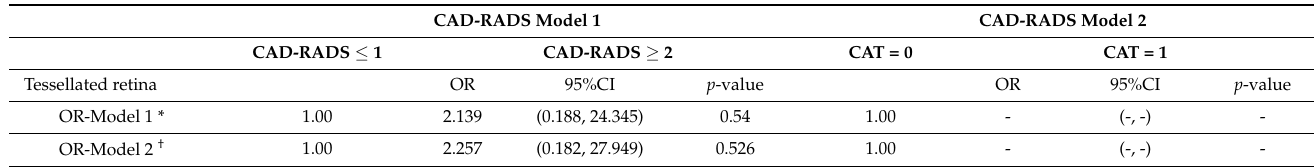
Table 2. CAD-RADS prediction models and eye